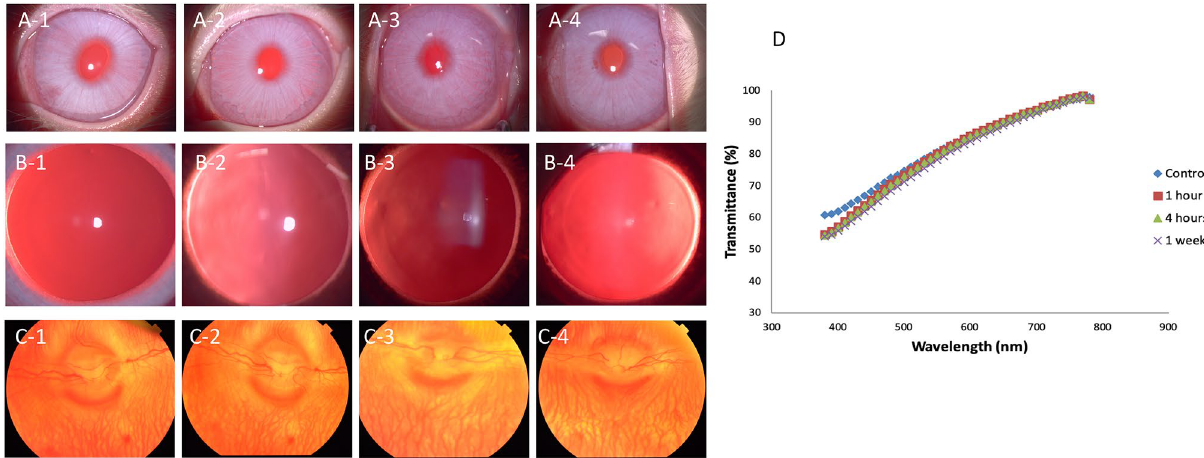
Figure 1. Clinical observation with slit lamp biomicroscopy ( A , B ) and fundus photography ( C ) for the control, 1 h, 4 h and 1 week after 4 h-exposure groups, respectively. Spectrum-wide transmittance trends of the corneas in different groups were also shown ( D ). The corneas remained clear without corneal haze formation ( A1 – A4 ), the lens were clear with no opacity ( B1 – B4 ), and there were no signs of vitritis, retinitis or optic neuropathy ( C1 – C4